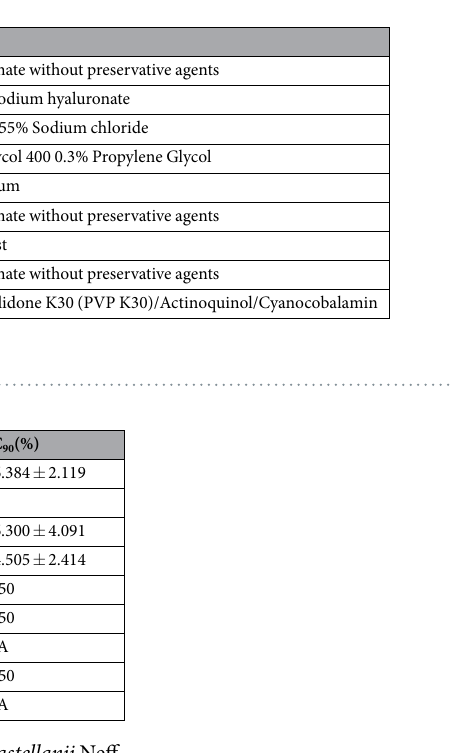
Table 2. Activity against Acanthamoeba castellanii Neff.